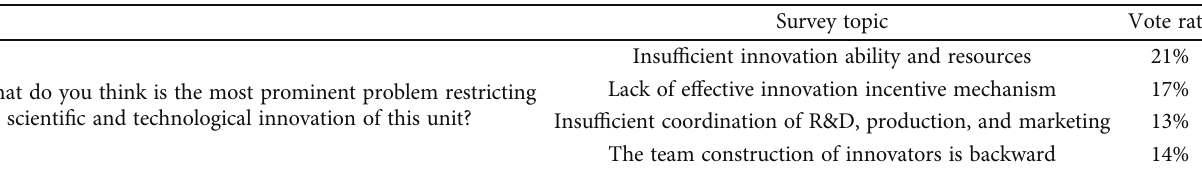
Table 9: List of votes obtained for open-ended question 1.